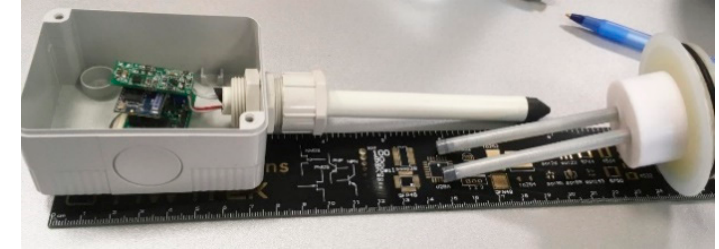
Figure 12. One-rod and two-rod sensor configurations.